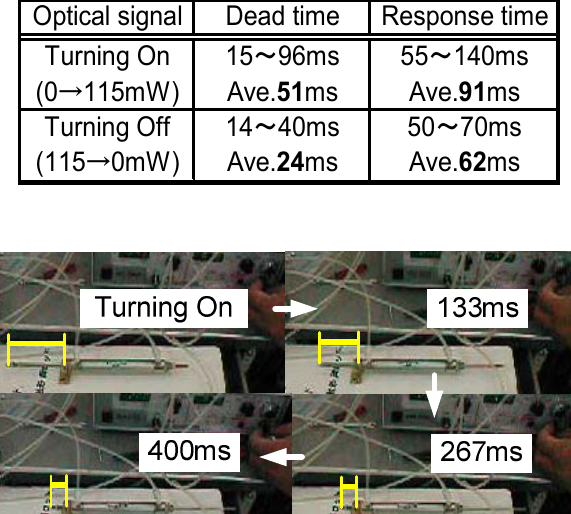
Dynamic characteristics of the photo-fluidic control valve Optical